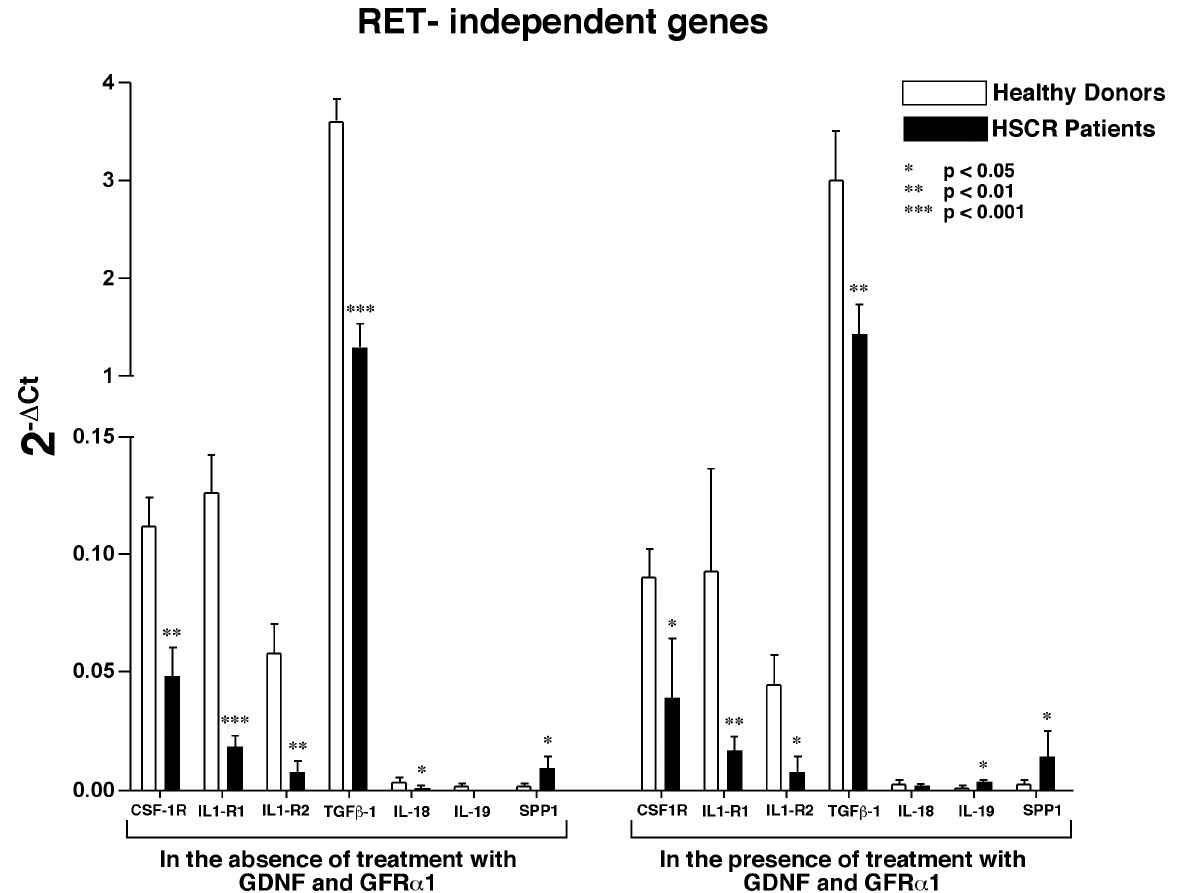
Figure 6. Modulation of RET-independent genes. Histogram bar graph showing the relative transcript levels of genes that, regardless of treatment with GDNF and GFR a 1, are differently modulated in PBMCs from healthy donors and HSCR patients. The amounts of mRNA either in freshly purified (left part of the graph) or treated (right part of the graph) of PBMCs of healthy donors (white bars) and HSCR patients (black bars) were detected by Taqman Low Density Array (TLDA) card.